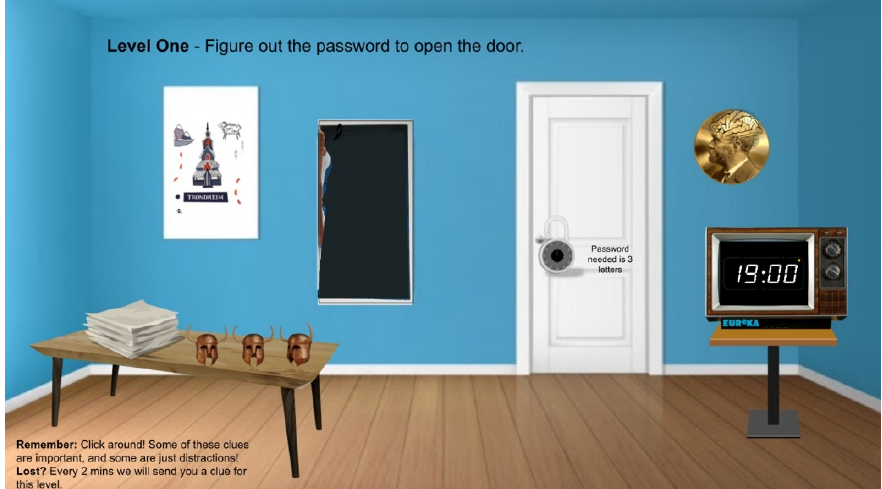
Figure 6. Use of Google Slides to Create a Virtual Escape Room 7. Enhancing the Digital version (via Google Slides): To develop an ER concept further, Google Slides can be used to simulate the ‘room’ itself and to add functionality such as a timer and hyperlinks to clues and resources. An example was used at the 2021 3E Entrepreneurship Educators Conference as an icebreaker exercise (Figure